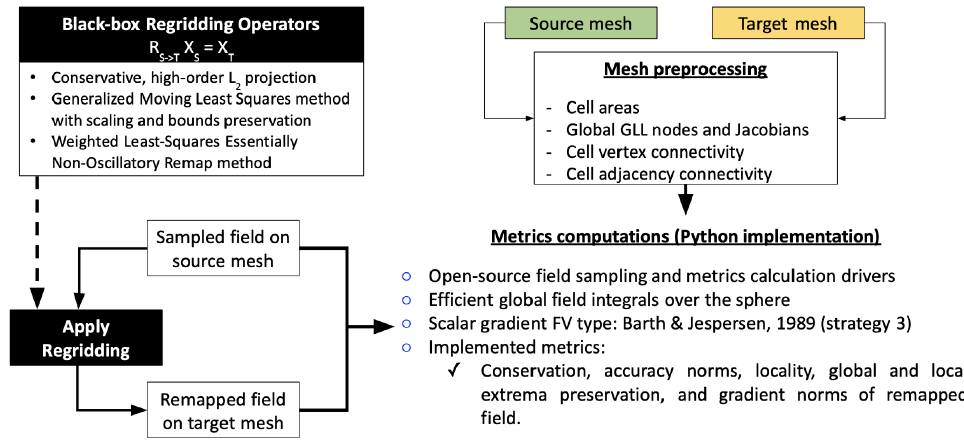
Figure 2. The MIRA workflow for generating the remapping metrics for the intercomparison study.